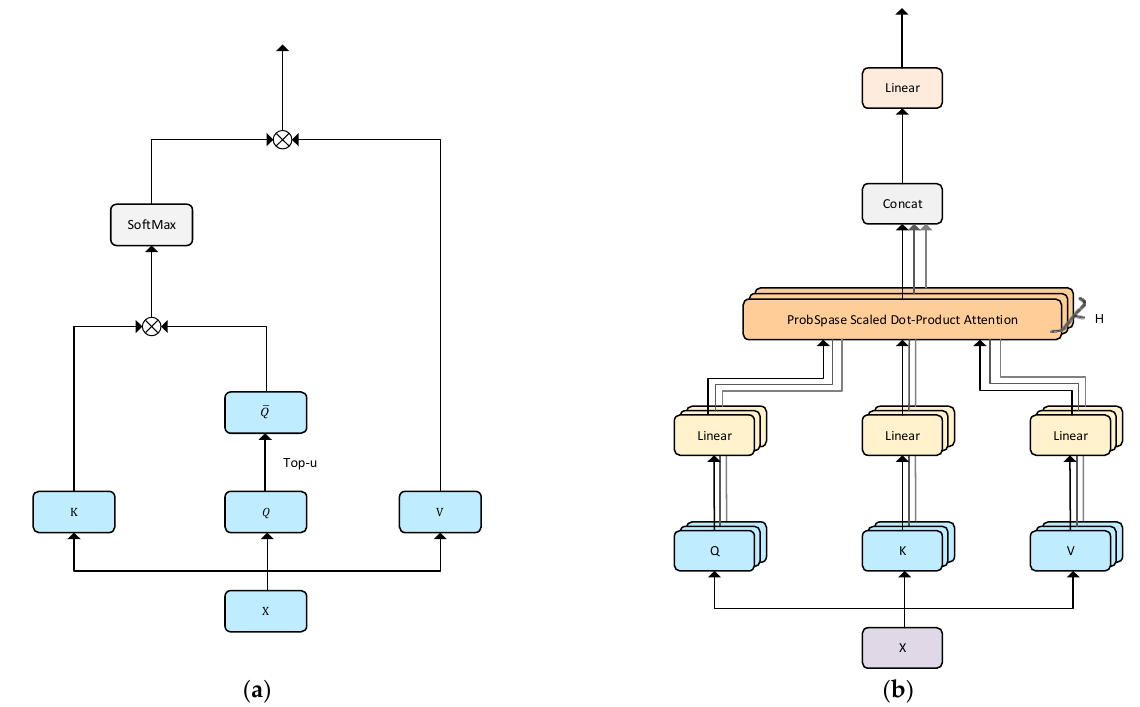
Figure 2. ( a ) ProbSparse self-attention; ( b ) multi-head attention layer. In the following, 𝑞 (cid:3036) , 𝑘 (cid:3036) and 𝑣 (cid:3036) respectively represent the 𝑖 -th line in 𝑄 , 𝐾 and 𝑉 .